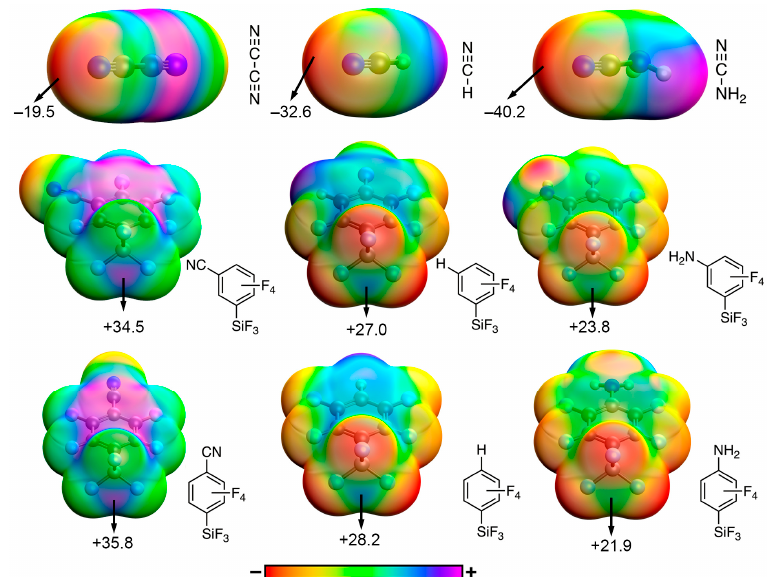
Figure 2. Electrostatic potential surfaces (ESP) of some selected compounds used in this study. The energy values given at selected points in the surface are in kcal/mol using an isovalue of 0.001 a.u. The ESP values corresponding to the rest of the compounds are gathered in Table 1. Table 1. Values of the electrostatic potential surface (ESP, in kcal/mol) for both tetrel bond donors (TtB donor, measured at the Si atom) and acceptor (TtB acceptor, measured at the N atom) molecules used in this study.